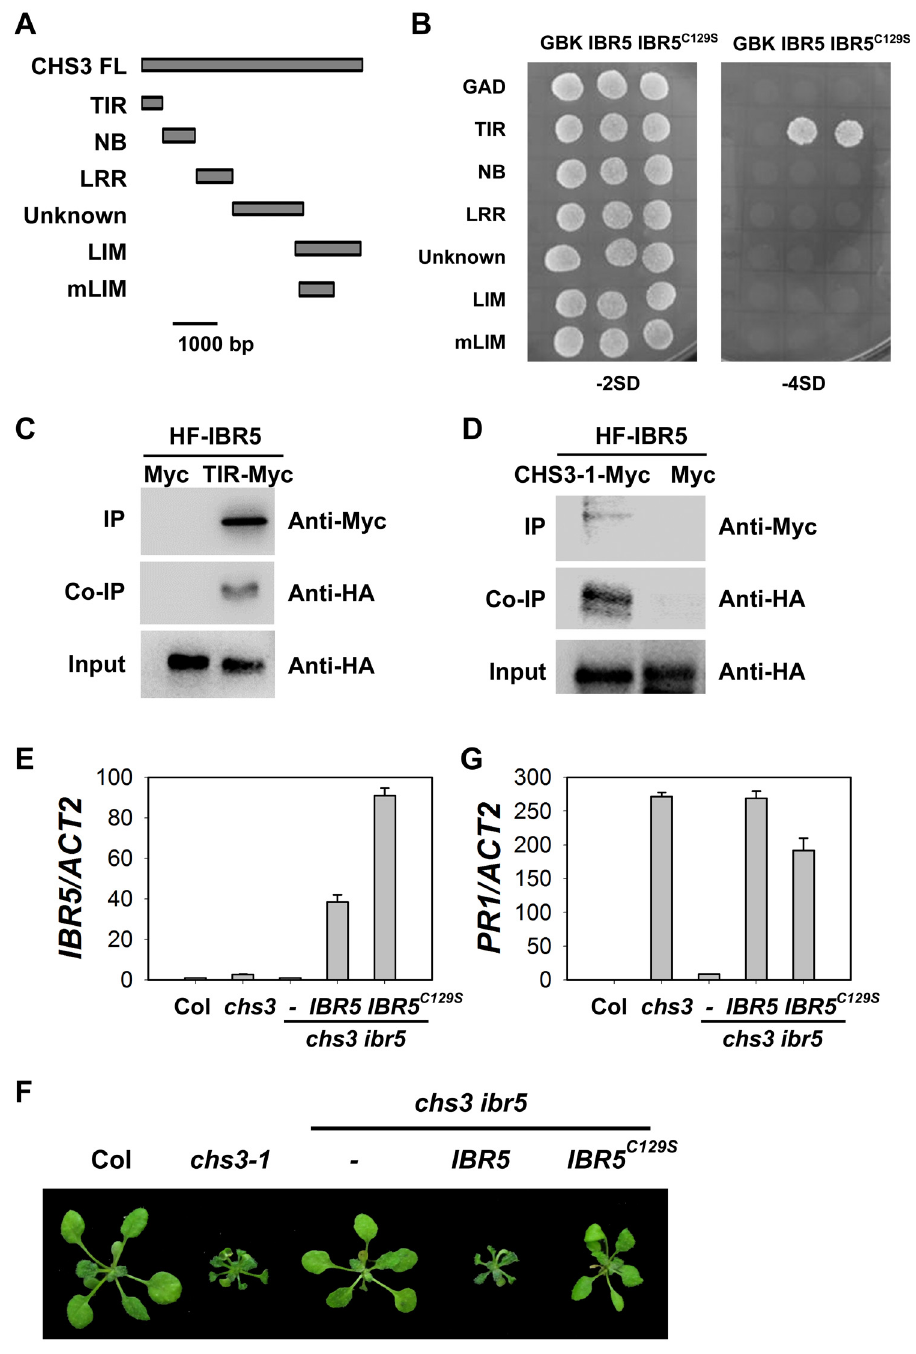
Fig 3. Interaction of IBR5 with CHS3. (A) Predicted protein structure of CHS3. TIR, Toll/Interleukin – 1 receptor domain (aa 1 – 138); NB, nucleotide binding domain (aa 139 – 468); LRR, leucine-rich repeat domain (aa 469 – 729); Unknown, domain with no known function (aa 730 – 1240); LIM, LIM (Lin-11, Isl-1 and Mec-3 domains)-containing domain (aa 1135 – 1614); mLIM, LIM-containing domain with the same mutation in chs3- 1 , which contains a stop codon at 1422. (B) Interaction between IBR5 and CHS3 in yeast. The different CHS3 domains shown in (A) were fused with the pGADT7 vector. IBR5 and mutated IBR5 C129S were fused with the pGBKT7 vector. The constructs were transformed into AH109 yeast cells and spotted onto SD media lacking Trp and Leu (-2SD) or lacking Trp, Leu, His and Ade (-4SD). The experiments were performed four times with similar results. (C) Co-immunoprecipitation of IBR5 and the TIR domain of CHS3. Total proteins were extracted from protoplasts expressing 35S : HA-Flag-IBR5 ( 35S : HF-IBR5 ) with Super : TIR domain of